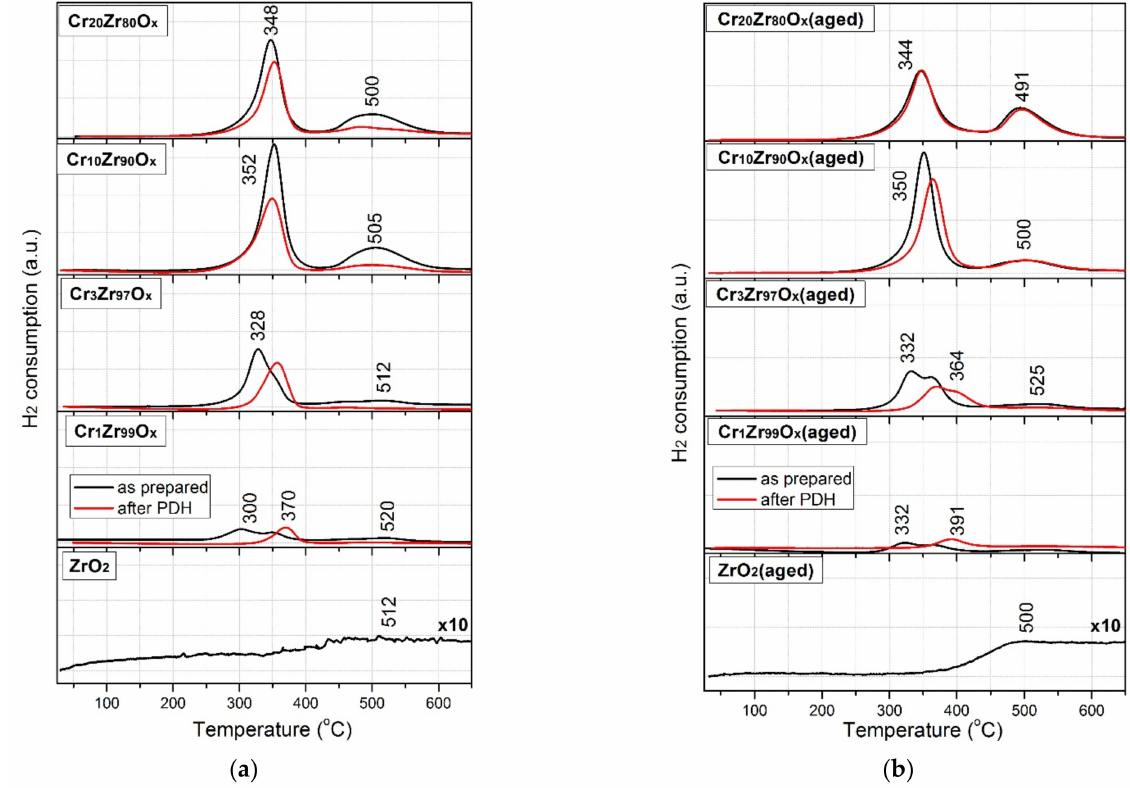
Figure 4. TPR-H 2 profiles for ZrO 2 and CrZrO x catalysts: catalysts ( a ) without ageing, ( b ) with ageing of